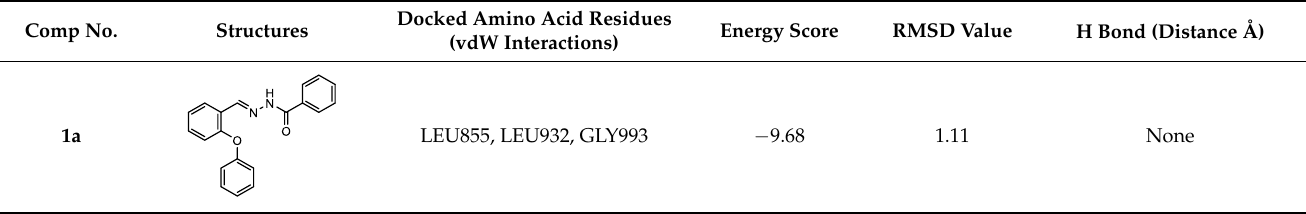
Table 4. Docking results of Janus kinase 2 (3KRR).